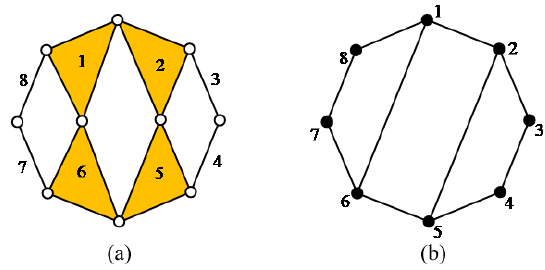
Figure 1. (a) An 8-link 1-DOF kinematic chain and (b) its graphic representation.